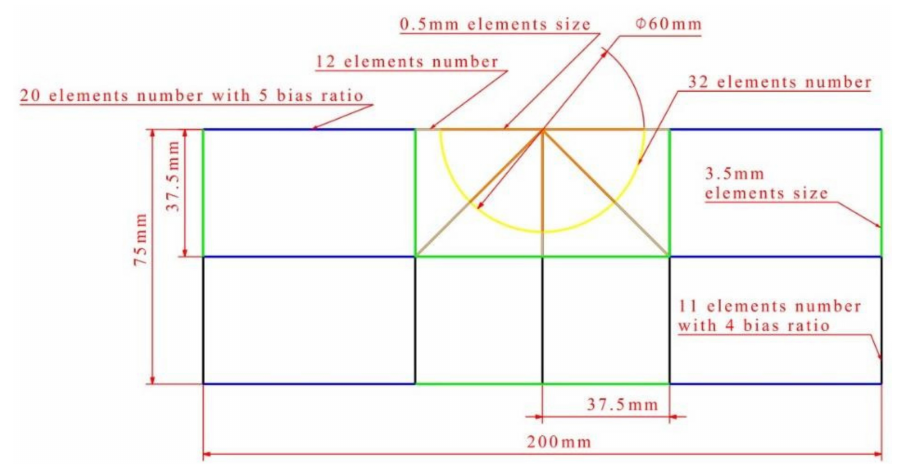
Figure 5. The geology and mesh size of the finite element